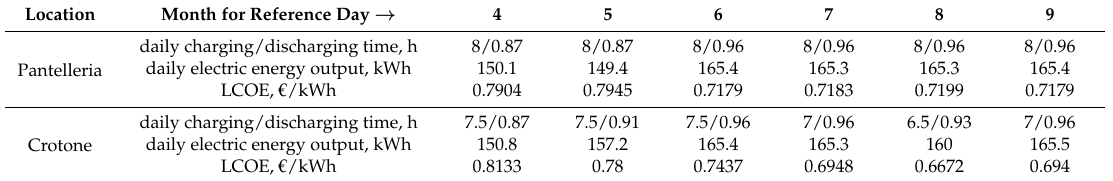
Table 9. Variation of electricity yield and electricity cost over the seasons.